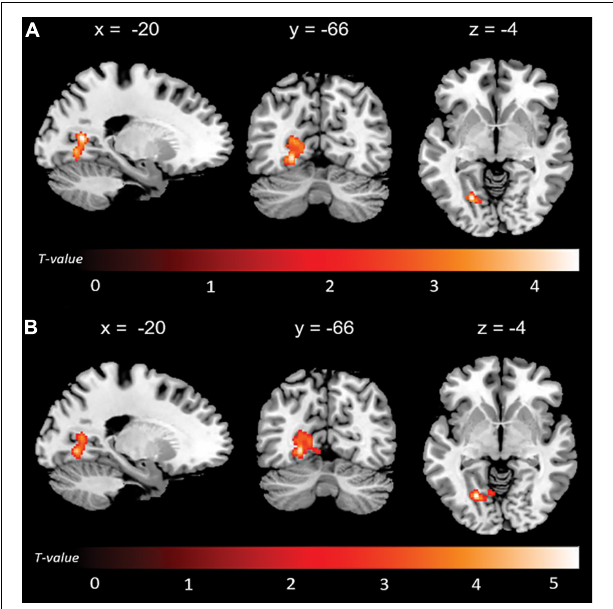
FIGURE 3 | Positive correlations between functional connectivity of the anterior default mode network (aDMN) and (A) non-memory and (B) total